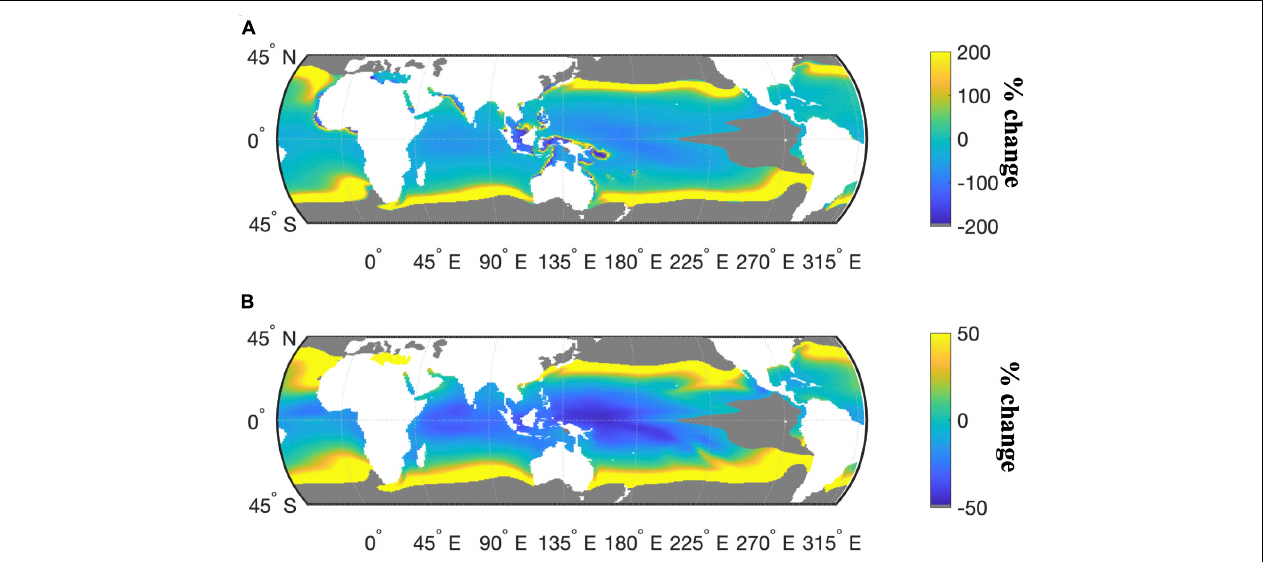
FIGURE 3 | Percent change in the modeled response of Crocosphaera N-IUE (mol N fixed h − 1 mol Fe − 1 ) (A) and N 2 -fixation (fmol N h − 1 cell − 1 ) (B) for the years 2010 and 2100 under the IPCC RCP 8.5 warming scenario. Gray masked areas exclude areas where nitrate concentrations are > 5 µ M or where temperatures are outside the thermal range, and where modeled growth rates are consequently assumed to be negligible ( < 0.01 day − 1